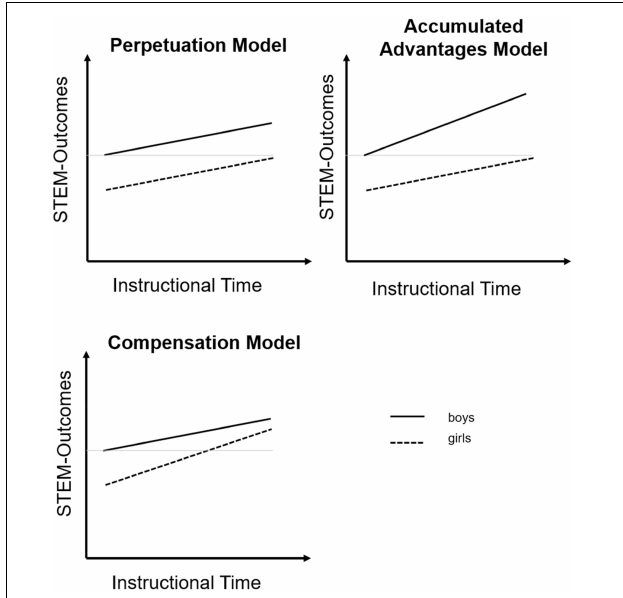
FIGURE 1 | Hypothetical effects of the school time reform on gender disparities in math-intensive STEM